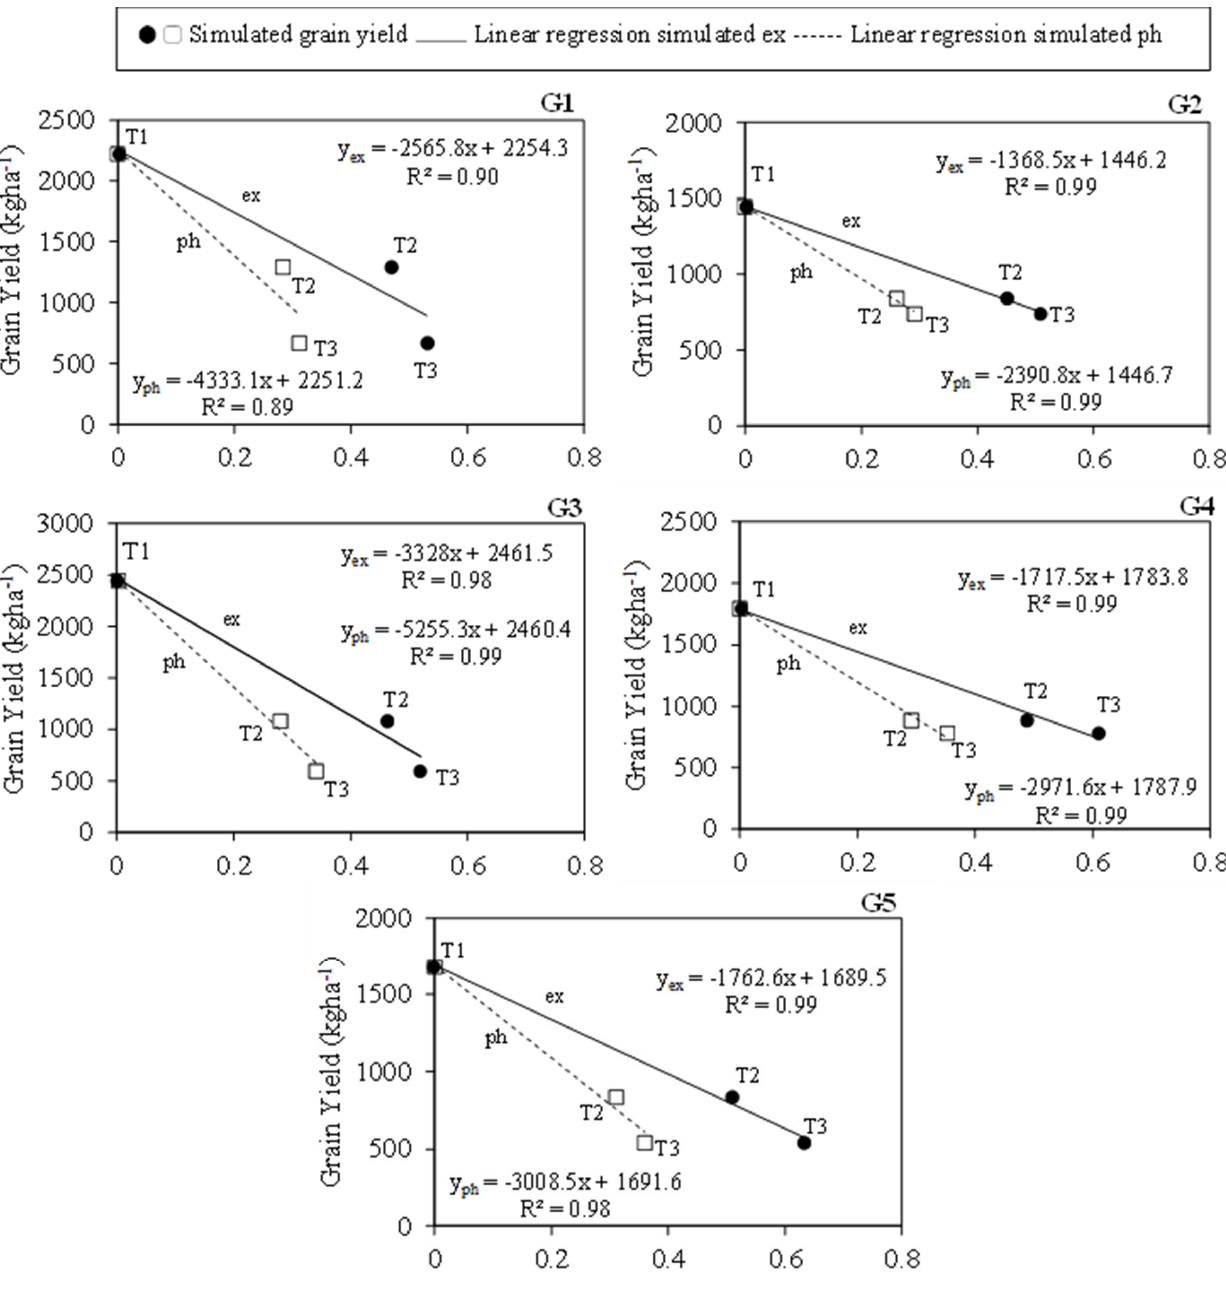
Figure 8. Linear regression relationship between the simulated grain yield and the average drought stress for photosynthesis (ph) and between the simulated grain yield and average drought stress for growth expansion (ex) for genotypes in group A under T1: control (100% FC), T2: moderate stress (70% FC), and T3: severe stress (50% FC) treatments in the yield assessment experiment.